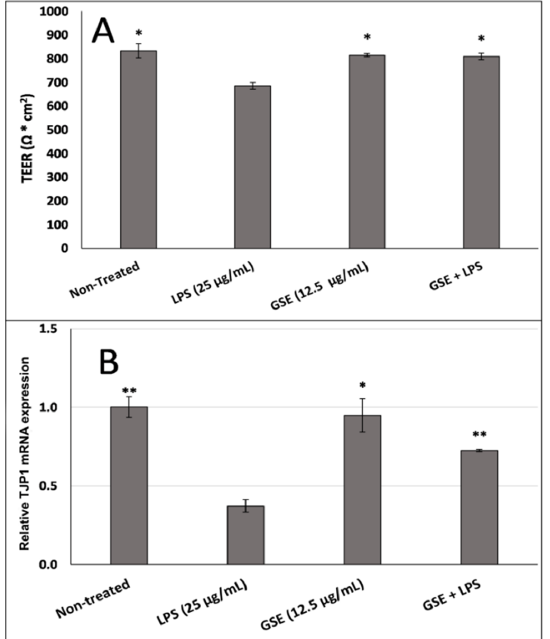
Figure 4. Effect of GSE on electrical resistance across ( A ) the tight junction barrier integrity measured by transepithelial electrical resistance (TEER) and ( B ) TJP1 gene expression in Caco-2 cells were significantly reduced in LPS-treated cells and restored by cotreatment with GSE. Error bars indicate ± S.D. ( n = 3). * and ** indicate the data were significantly different relative to LPS-treated cells with p ≤ 0.05 and p ≤ 0.01 respectively using Tukey’s test.